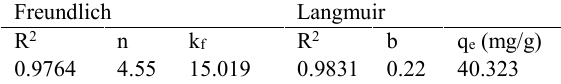
Table 4. Parameter value of Langmuir and Freundlich isotherm model for MCPAC